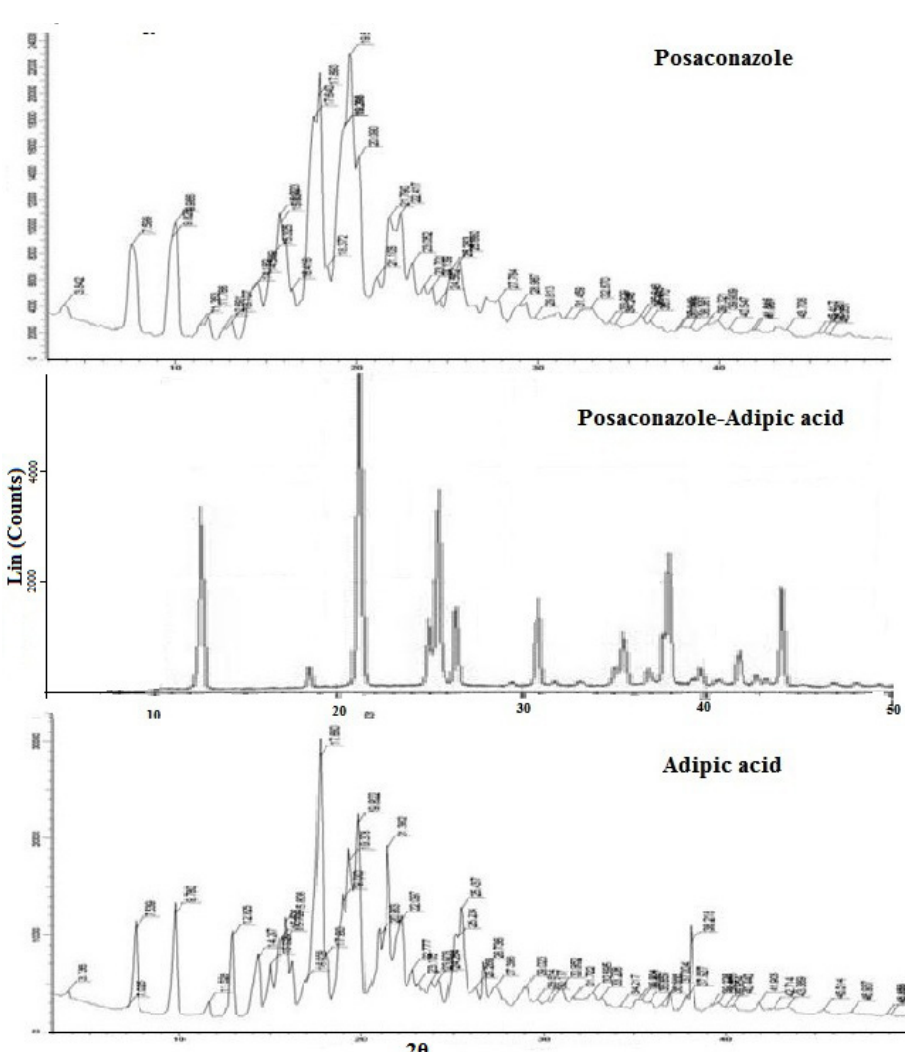
FIGURE 2 - PXRD pattern of posaconazole-adipic acid co-crystal and its individual